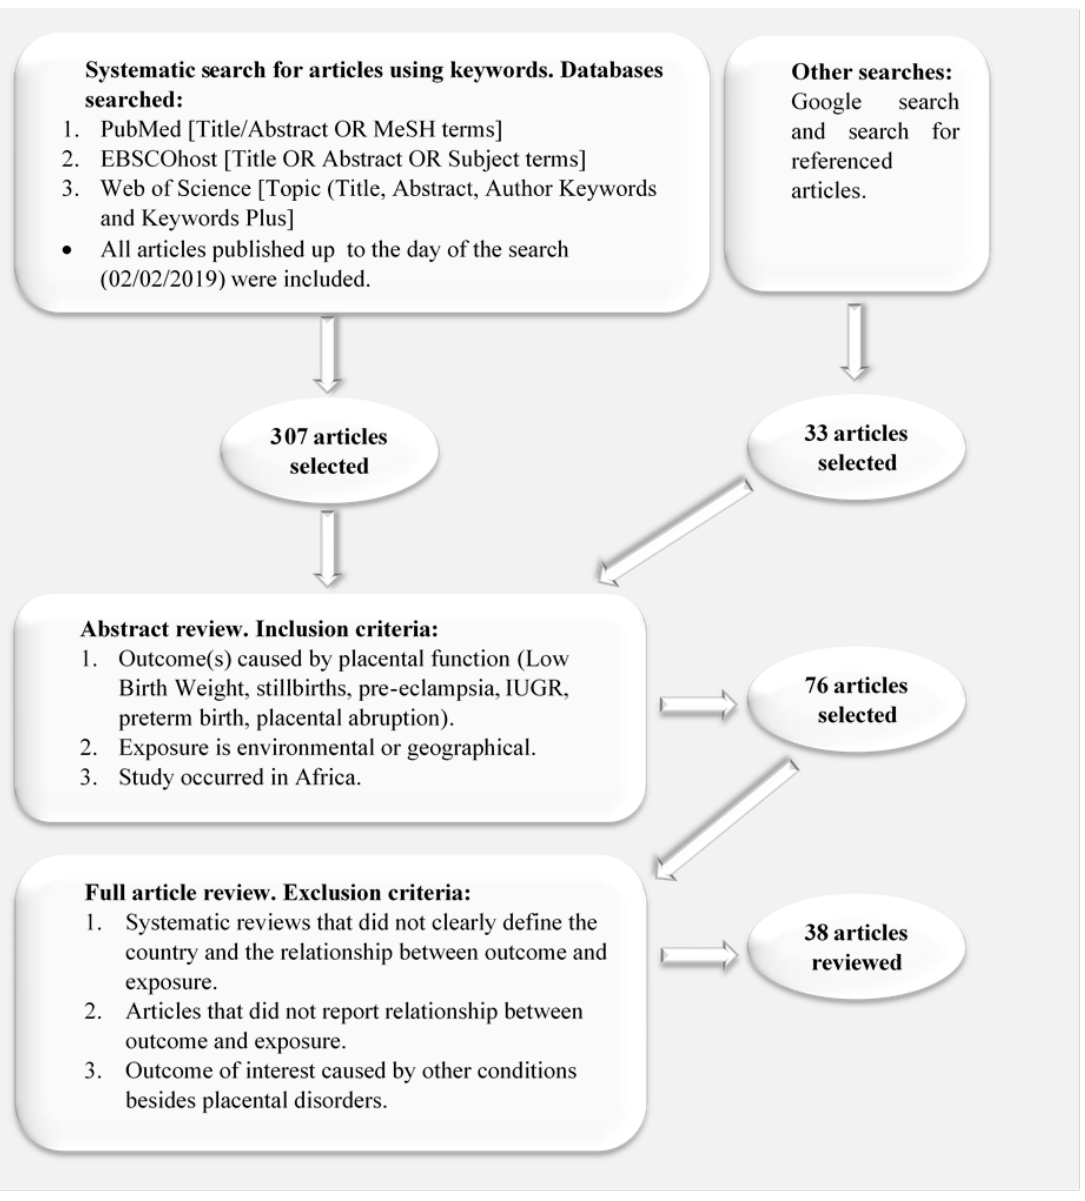
Figure 1. Diagrammatic illustration of the methodology adopted in selecting relevant articles for this scoping review write-up.